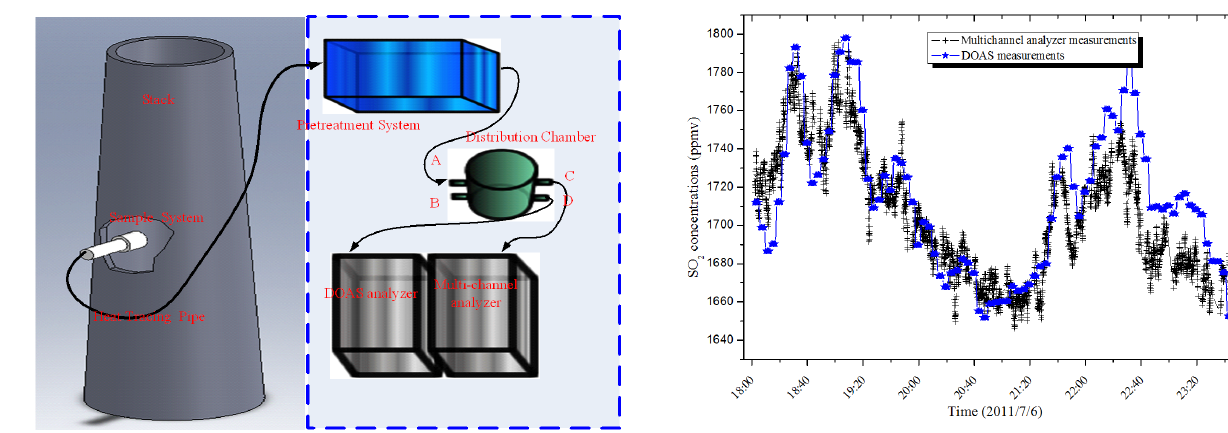
Figure 12. Setup for stack measurements with the multichannel an- alyzer and a DOAS analyzer. A detailed description of a similar setup can be found in Sun et al. (2013).